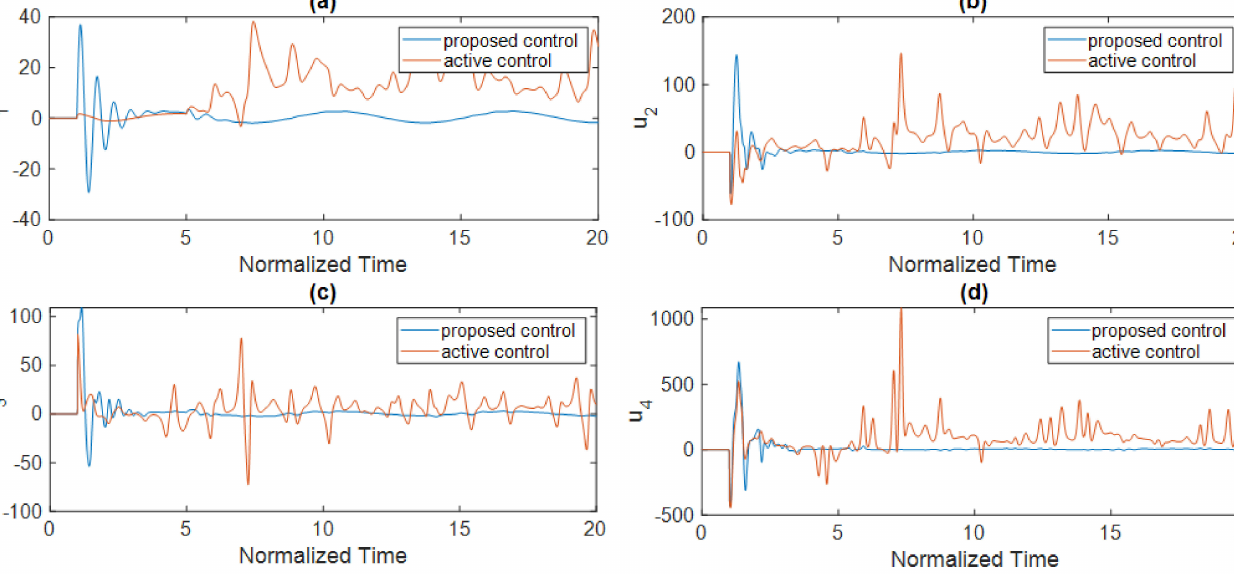
Figure 10. The control input based on the proposed control methodology and active control, where there are both bias faults and partial loss of effectiveness. Time history of ( a ) u 1 , ( b ) u 2 , ( c ) u 3 , ( d ) u 4